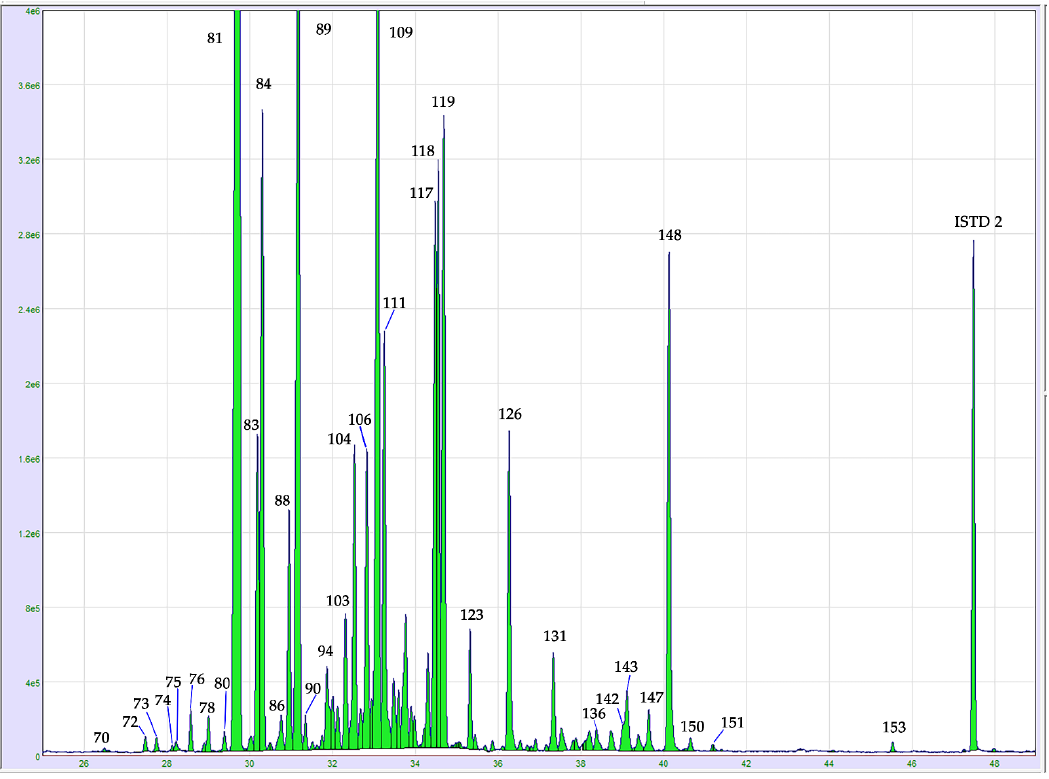
Figure 3. GC-MS chromatogram expansion of the sesquiterpenes region in dried hemp inflorescences, cv. Finola. For peak assignment, see the compounds listed in Table 1. Abbreviation: ISTD 2: nonadecane internal standard.